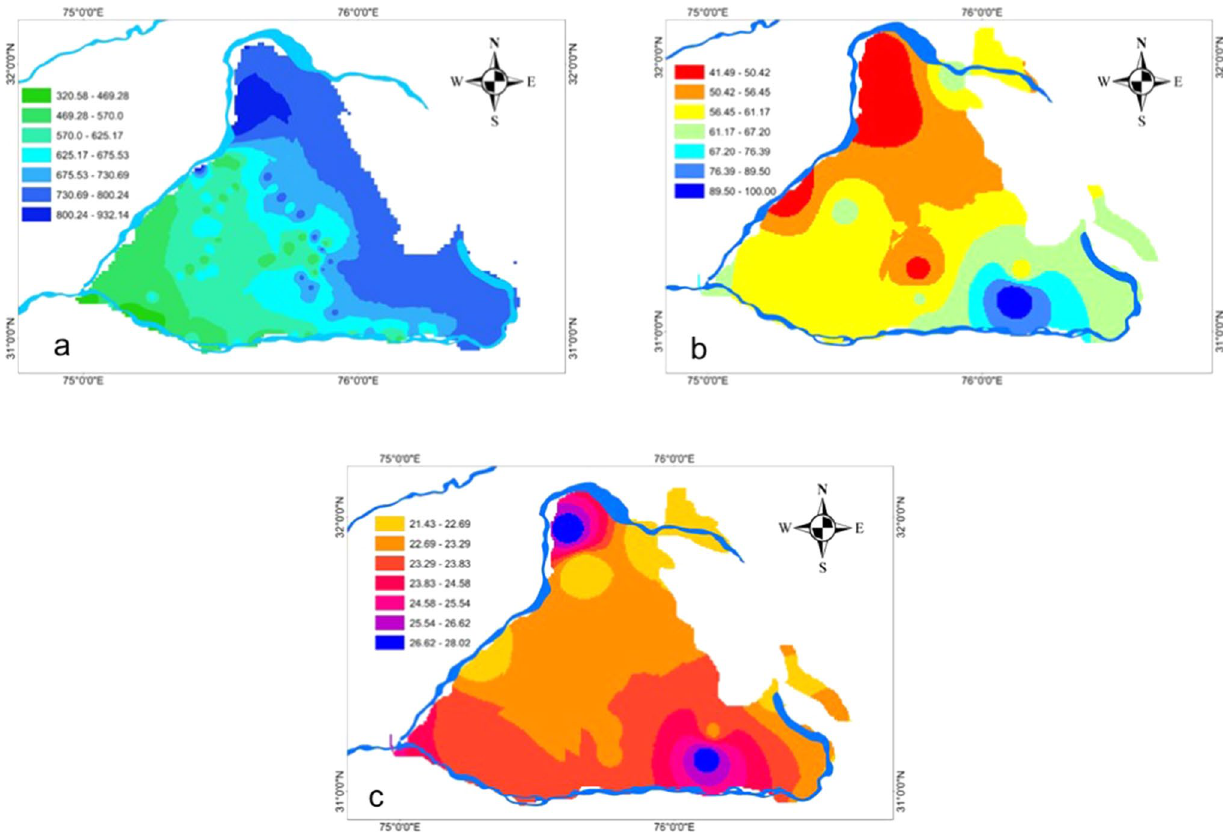
Fig. 2 The rainfall (mm) map of Bist interfluve is shown in a , the relative humidity (%) of the Bist interfluve is shown in b , and the tempera- ture (°C) is shown in c